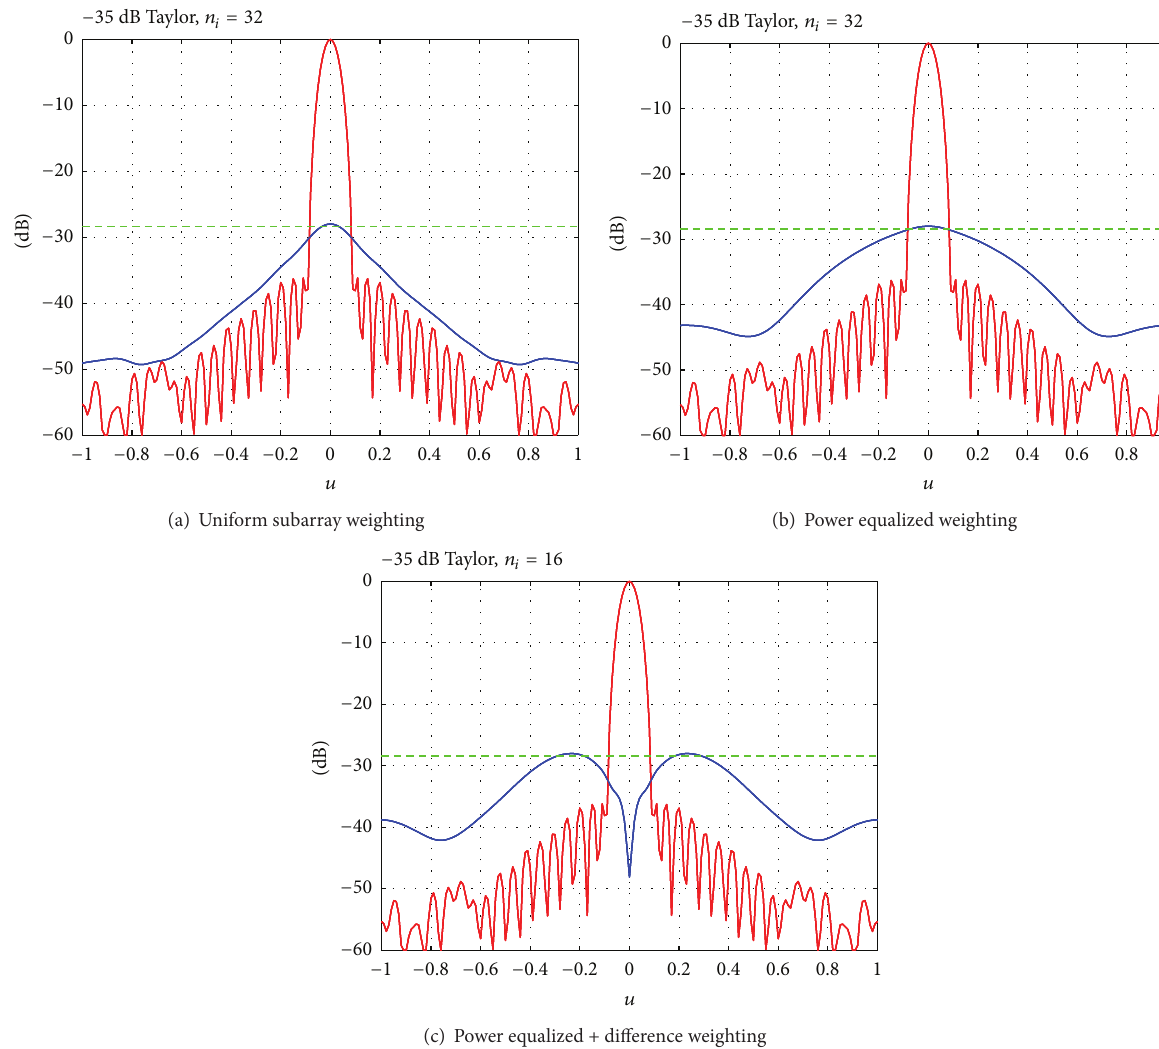
Figure 15: Guard channel and sum beam patterns for generic array of Figure